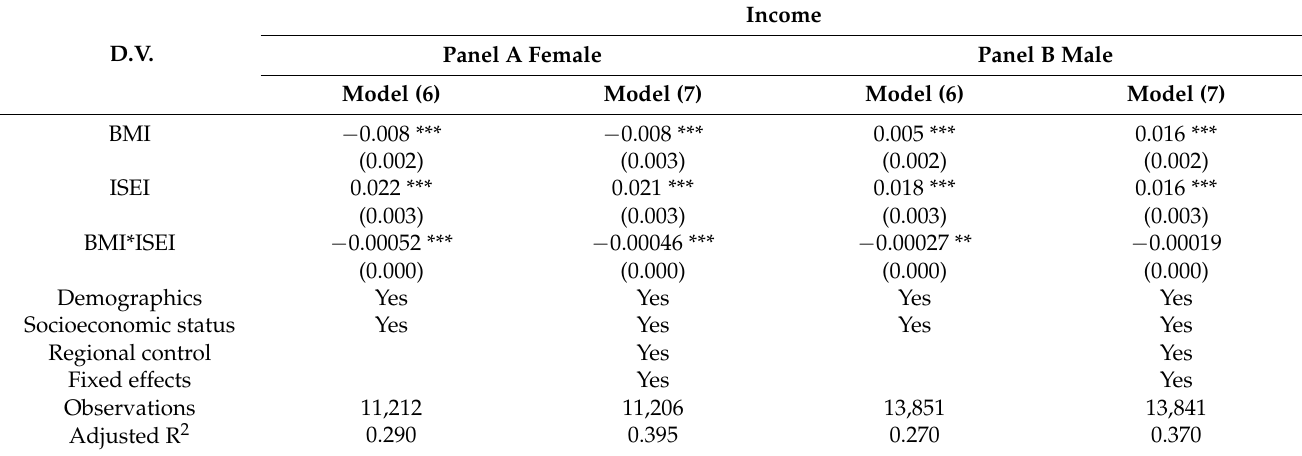
Table 4. Regression results of the interaction effect between BMI and